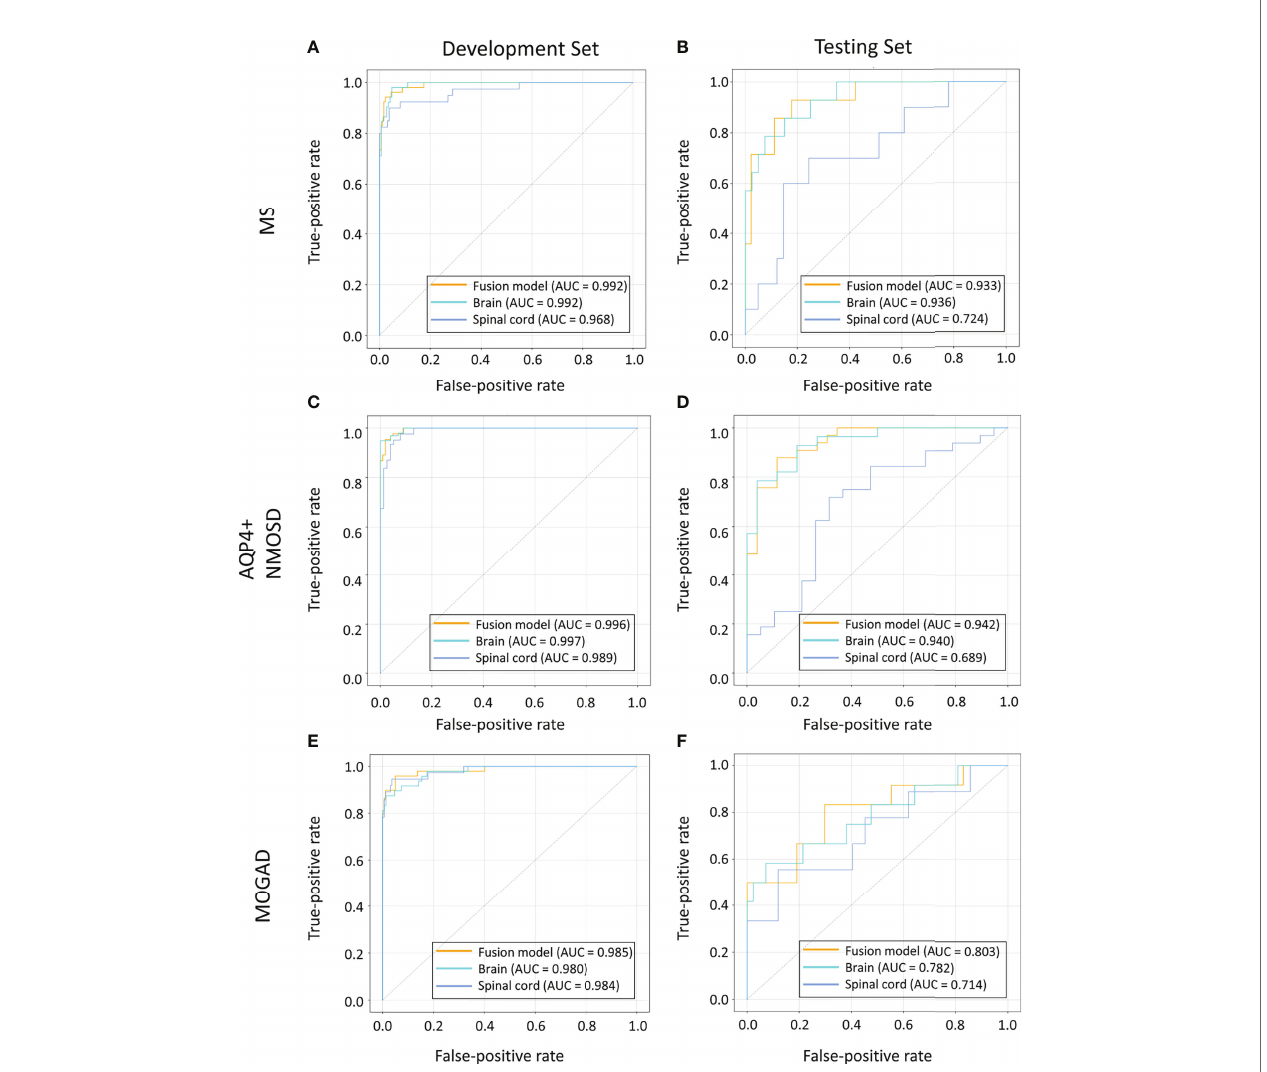
FIGURE 2 | ROC curves of the models based on brain, spinal cord, and combined MRI sequences in the cohorts of patients with MS (A, B) , AQP4+ NMOSD (C, D) and MOGAD (E, F) . AQP4+ NMOSD, aquaporin 4 positive neuromyelitis optica spectrum disorders; MOGAD, myelin oligodendrocyte glycoprotein antibody associated disease; MRI, magnetic resonance imaging; MS, multiple sclerosis; ROC, receiver operating